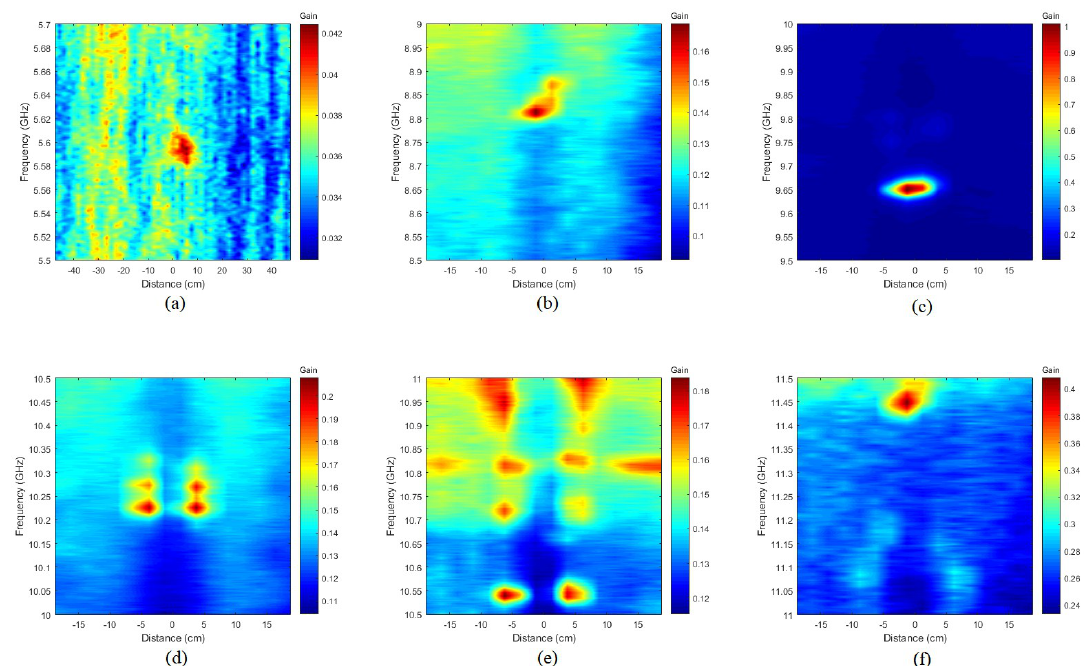
Figure 10. Phase-coded B-OCDA spectra along a silica micro-wire as a function of position for multiple frequency ranges [30]: ( a ) 5.5–5.7 GHz, ( b ) 8.5–9.0 GHz, ( c ) 9.5–10.0 GHz, ( d ) 10.0–10.5 GHz, ( e ) 10.5–11.0 GHz, and ( f ) 11.0–11.5 GHz. Position 0 cm is the center of the tapered fiber waist [30]. Reproduced with permission from [30], Optical Society of America, 2018.